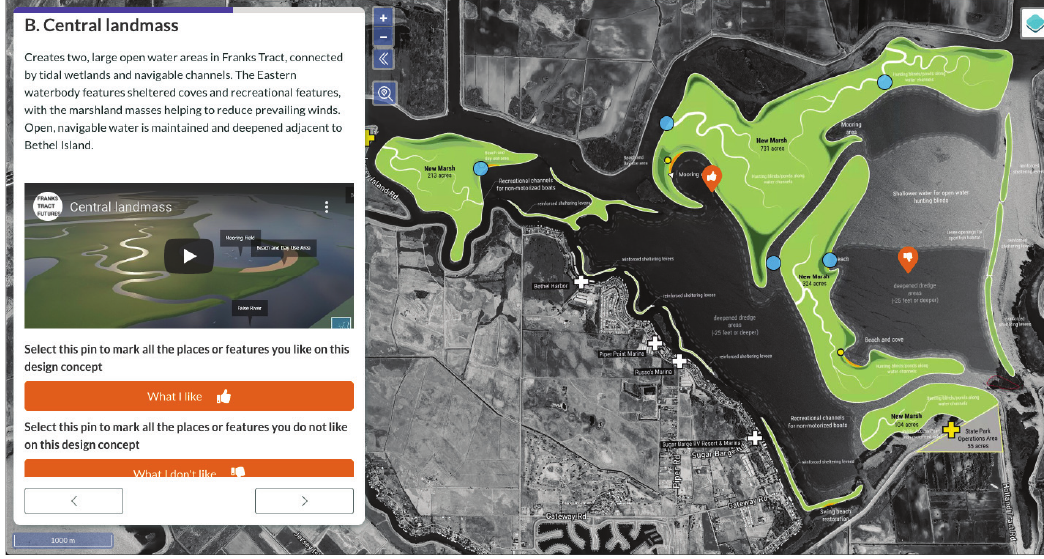
Figure 4. Image of the design concept survey